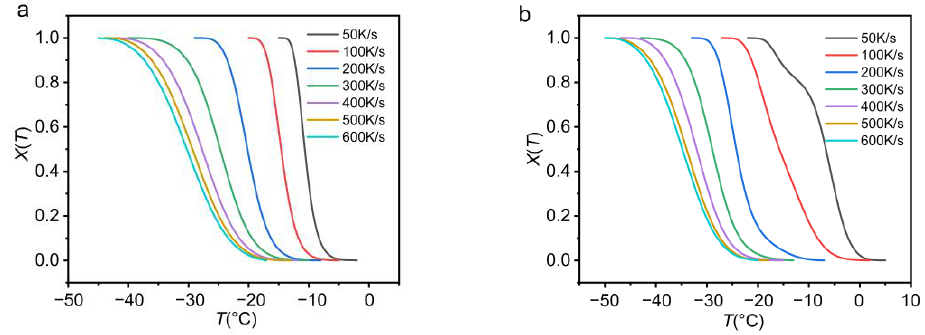
where T 0 and T ∞ represent the initial temperature and final temperature of the crystalliza- tion process, respectively. Figure 3a is the curve of relative crystallinity with temperature in the crystallization process of PEG. The relative crystallinity and the crystallization temperature are obvi- ously reverse S-shaped. Figure 3b is the curve of relative crystallinity with the temperature during the crystallization of PEG-PCL. The curve is not an obvious reverse s-shaped curve when the heating rate is 50 K/s. The reason is that the PEG block and PCL block of PEG- PCL crystallize at different temperatures. Therefore, the peak splitting behavior on the crystallization curve is obvious.